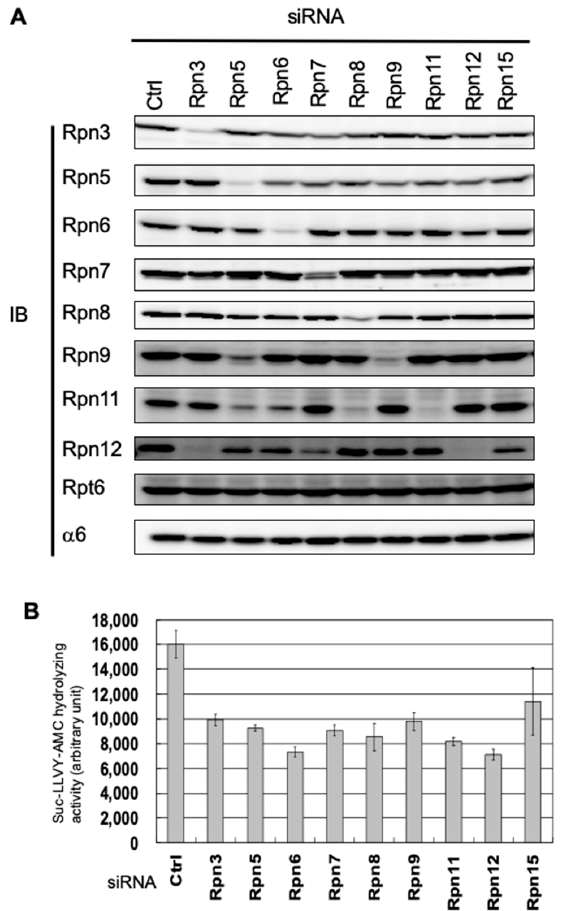
Figure 1. Interdependence between the lid subunits for protein expression. ( A ) siRNAs